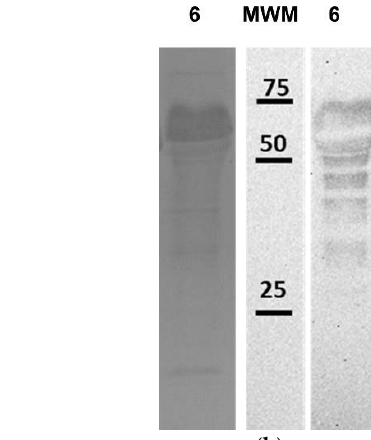
Figure 2. ( a ) Representative SDS-PAGE analysis of the purification process for BMAP18-SELP by salting out with ammonium sulfate at 20% saturation: MWM—molecular weight marker (GRS Unstained Protein Marker from Grisp) in kDa; 1—crude cell lysate after sonication; 2—supernatant after acidification at pH 3.5; 3—supernatant after salting out; 4—fraction of the precipitated sample after salting out; 5—dialyzed protein sample. Gel was stained with 0.3 M CuCl 2 . ( b ) Representative SDS-PAGE (image on the left) and Western blot (image on the right) analysis of pure BMAP18-SELP (6) with unstained SDS-PAGE standard molecular weight marker (MWM, in kDa; BioRad). Purification of the A200-based protein polymers was achieved by ITC, resulting in highly pure protein factions (Figure 1). After three heating/cooling cycles (Figure 1a), a pure protein fraction was obtained, as demonstrated by presence of a single band around 100 kDa (lane 7, Figure 1b).